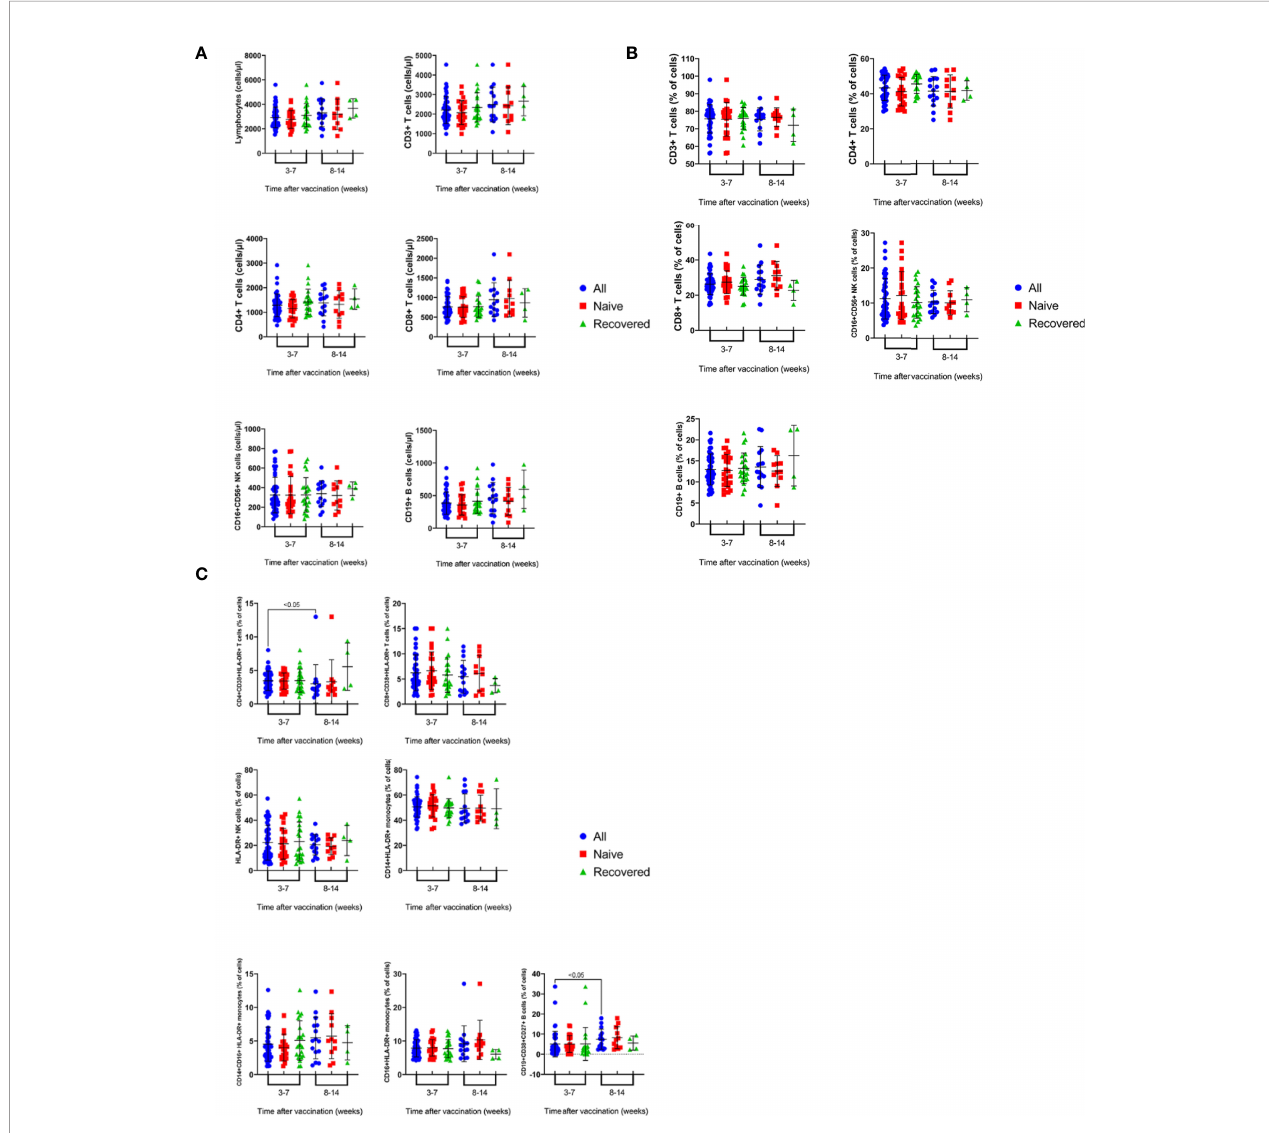
FIGURE 3 | Time course of changes in the absolute counts (A) and percentages (B) of immune cell subsets in the peripheral blood of recovered-vaccinated vs naïve vaccinated subjects over 3-14 weeks post vaccination. Results are shown for total lymphocytes, CD3+, CD4+ and CD8+ T cells, CD19+ B cells and CD16 +CD56+ NK cells and CD4:CD8 ratio. Each dot represents an individual donor. Data are presented as mean + SEM. (C) Time course of changes in the percentages activated immune cell subsets in peripheral blood of recovered-vaccinated vs naïve vaccinated subjects over 3-14 weeks post vaccination. Results are shown for CD38+HLA-DR+CD4+ and CD38+HLA-DR+CD8+ T cells, CD27+CD38+CD19+ B cells and monocytes subsets: CD14+HLA-DR+, CD16+HLADR+ and CD14 +CD16+HLA-DR+ cells. Data are presented as mean +